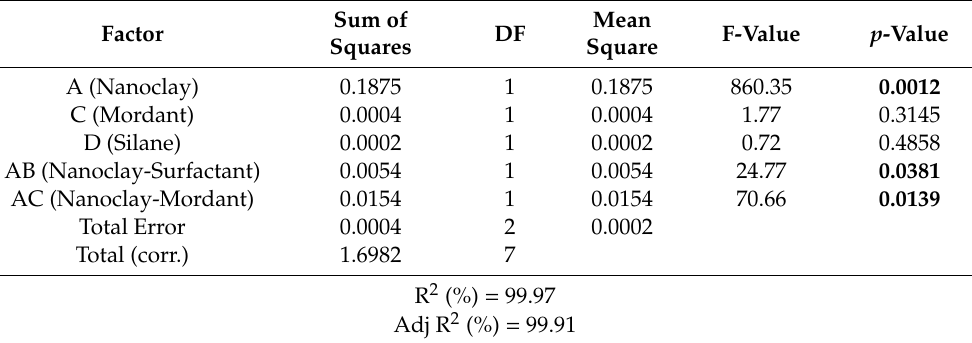
Table 5. Variance analysis for lemon dye synthesis